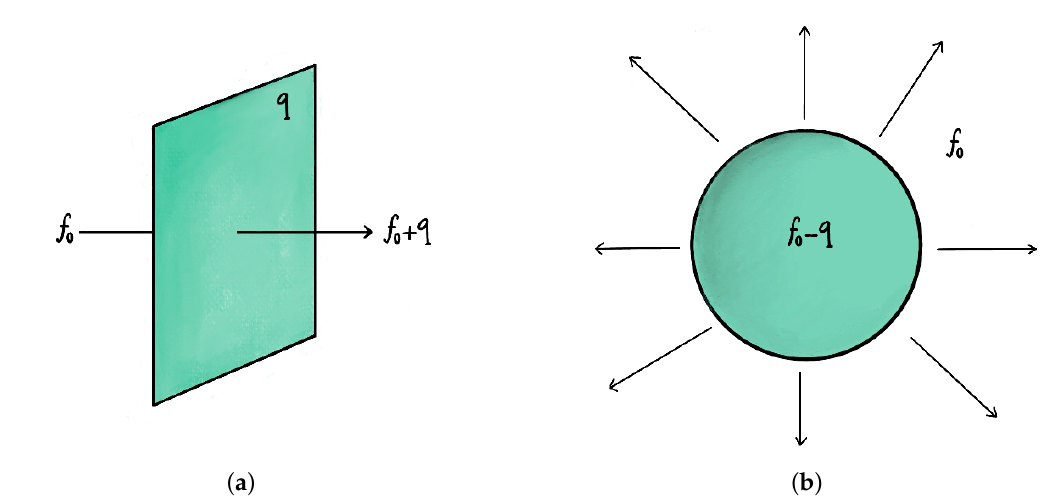
Figure 2. ( a ) Shift in a flux f 0 as a consequence of crossing a membrane with charge q under the dual 3-form. ( b ) Vacuum decay by nucleation of a bubble that expands and is surrounded by a membrane with charge q , such that the flux outside the bubble, f 0 , is reduced in the internal region of the